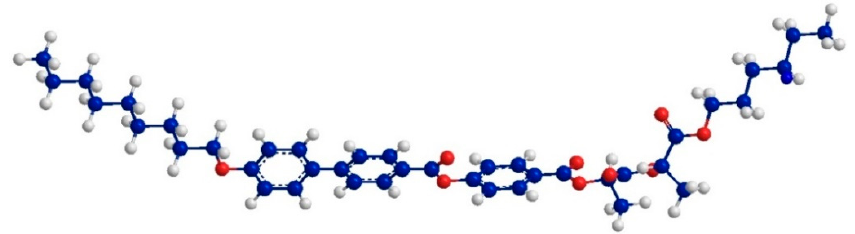
Figure 7. Conformation of the FLC molecule used for the PE-FLC nanocomposite after energy minimization using MOPAC / AM1 method. The length of the most extended conformer is 38.5 Å. Temperature dependence of the average distance, D, between the long axis of FLC molecules (i.e., intermolecular distance) measured by WAXS on cooling for the PE-FLC nanocomposite is presented on Figure 8. There is a continuous decrease of the intermolecular distance of the long molecular axis on cooling, indicating the increase of the positional order; no anomalies in intermolecular distance values are observed at the SmA*-SmC* phase transition (see Figure